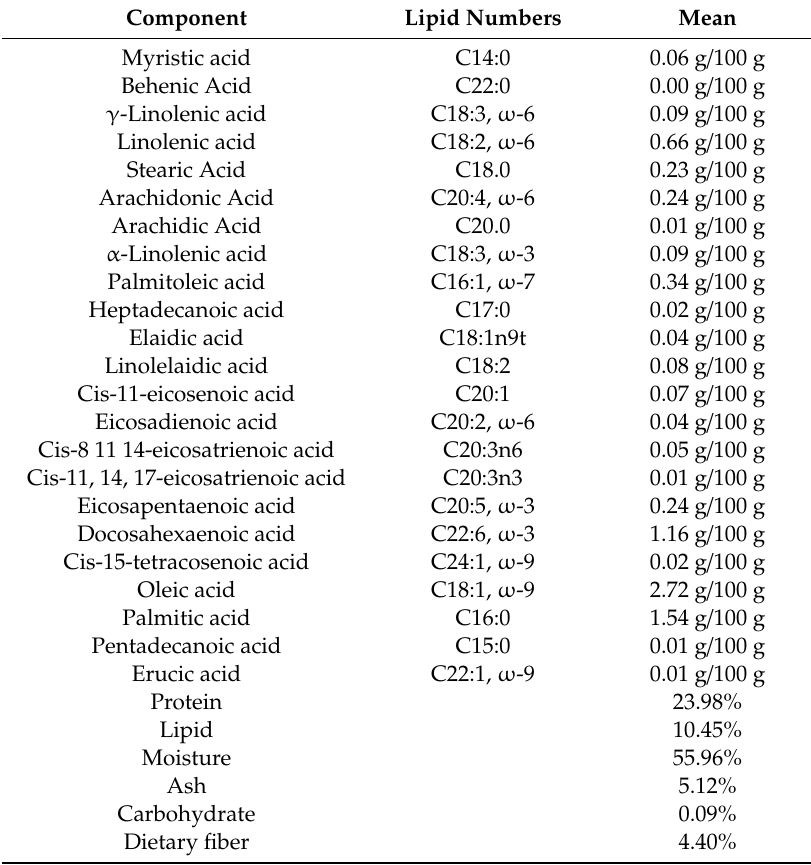
Table 1. Lipid composition of caviar